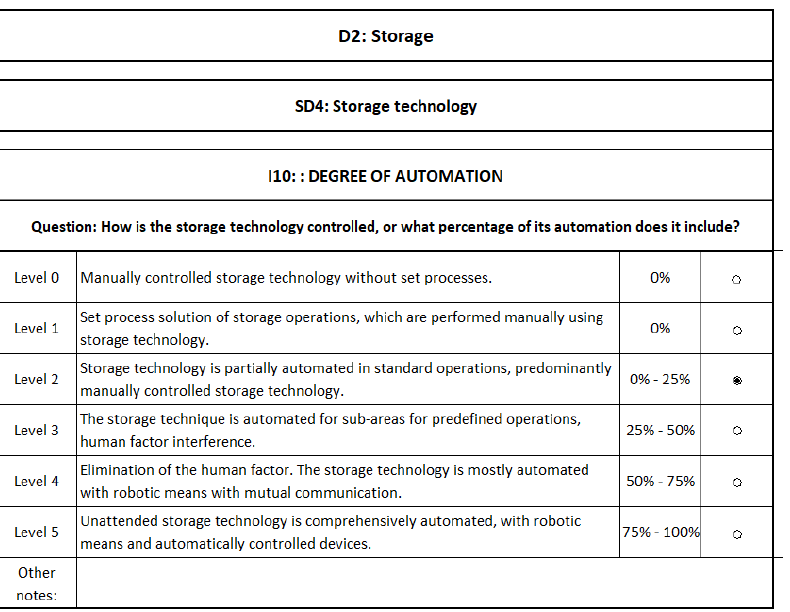
Figure 2. Question for I10: Degree of automation.